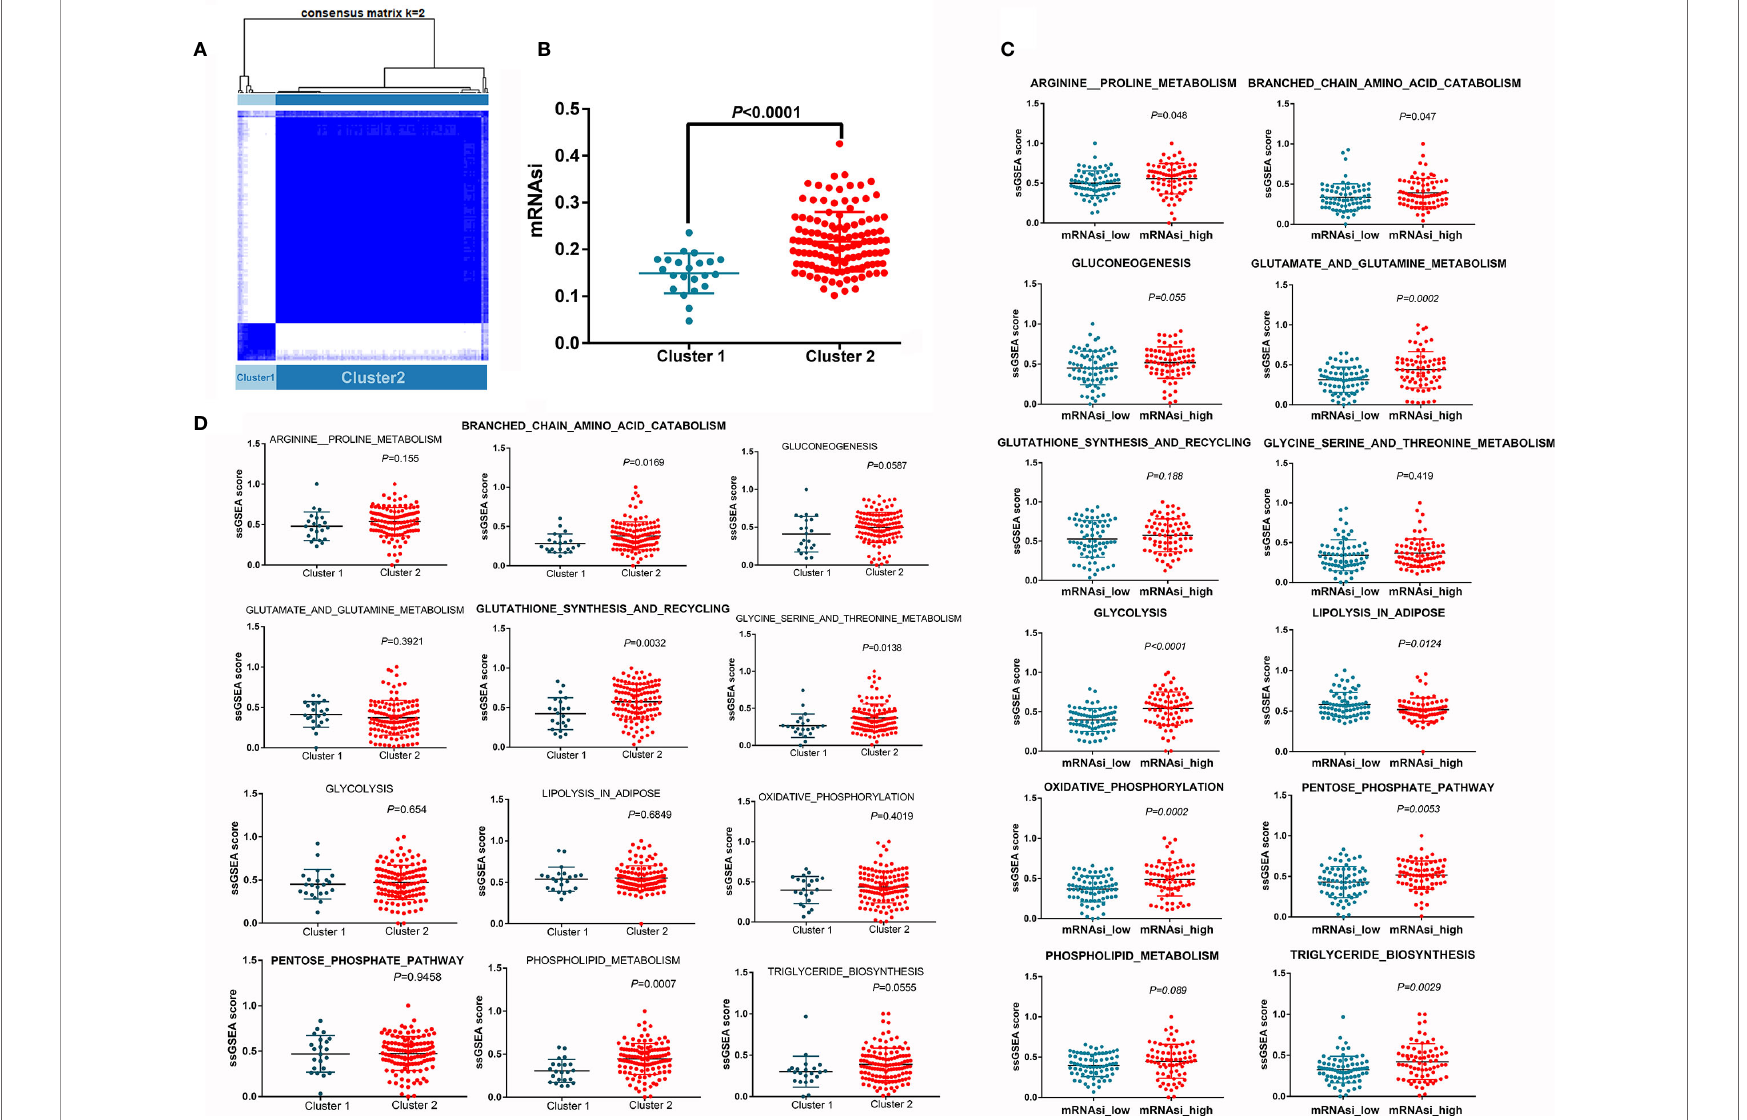
FIGURE 5 | Differences in metabolic pathway activity between different clusters. (A) Unsupervised clustering distinguished two clusters based on the selected key genes. (B) mRNAsi is increased in cluster 2. (C) Differences in metabolic pathway activity between the mRNAsi_high and mRNAsi_low groups. (D) Differences in metabolic pathway activity between clusters 1 and